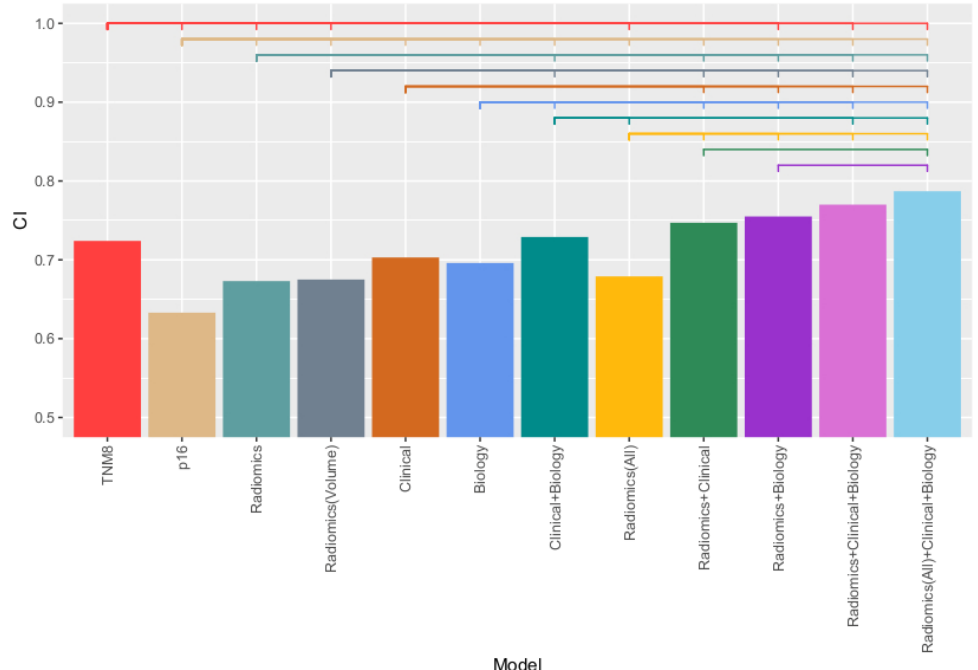
Figure 5. Bar plot of the various models validated on the validation cohort ( n = 143). The y -axis indicates CI value, while the coloured bars above the bar show significant differences between models, with an indent meaning the model is significantly different, and no indent meaning no significant difference was found.